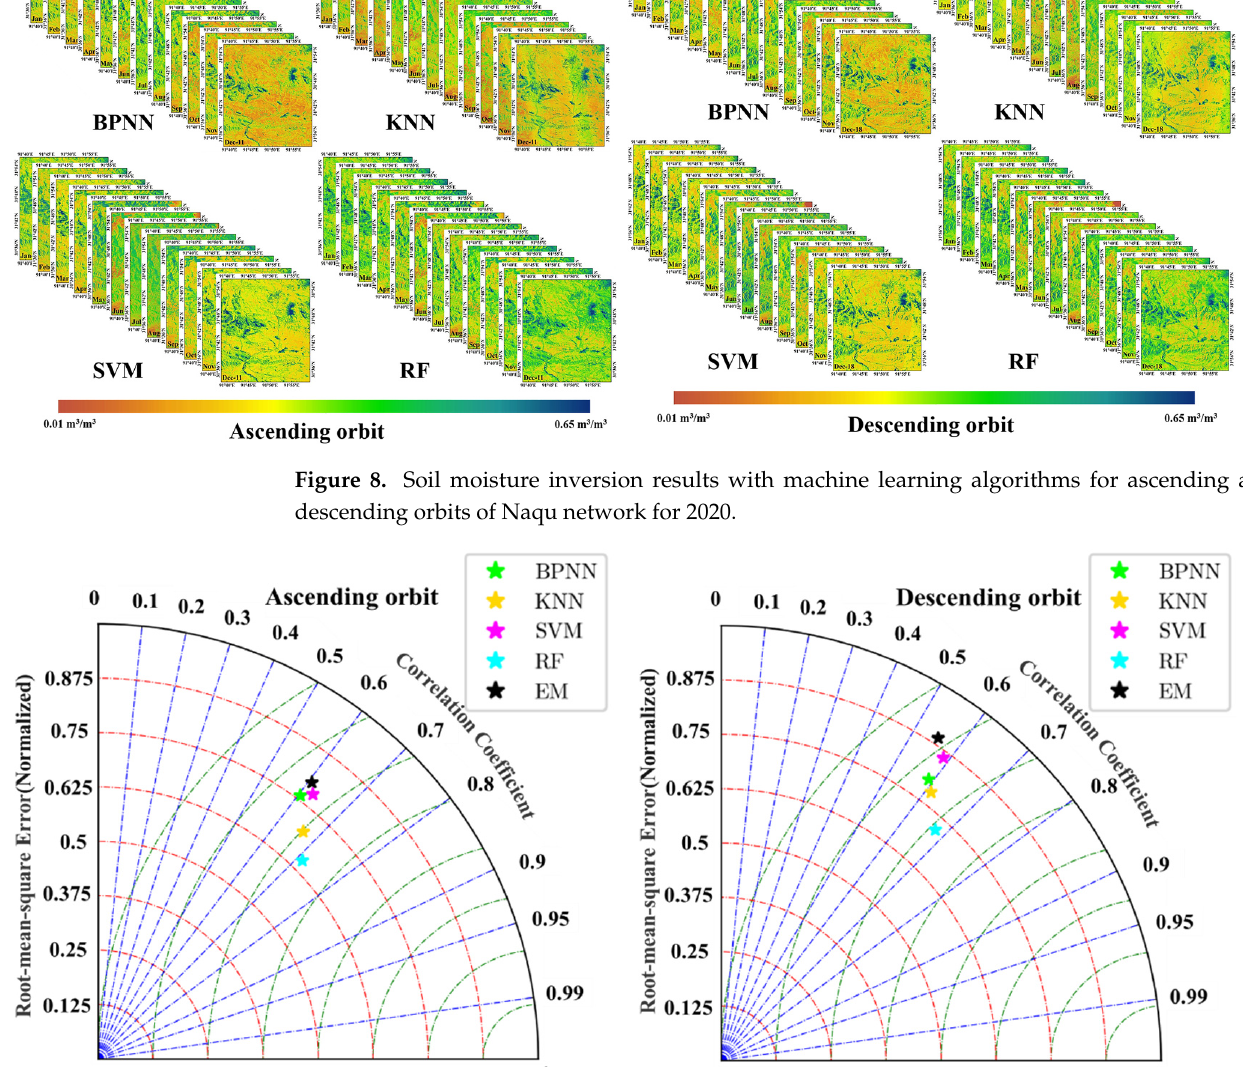
Figure 9. Comparison of soil moisture of different models for ascending and descending orbits.